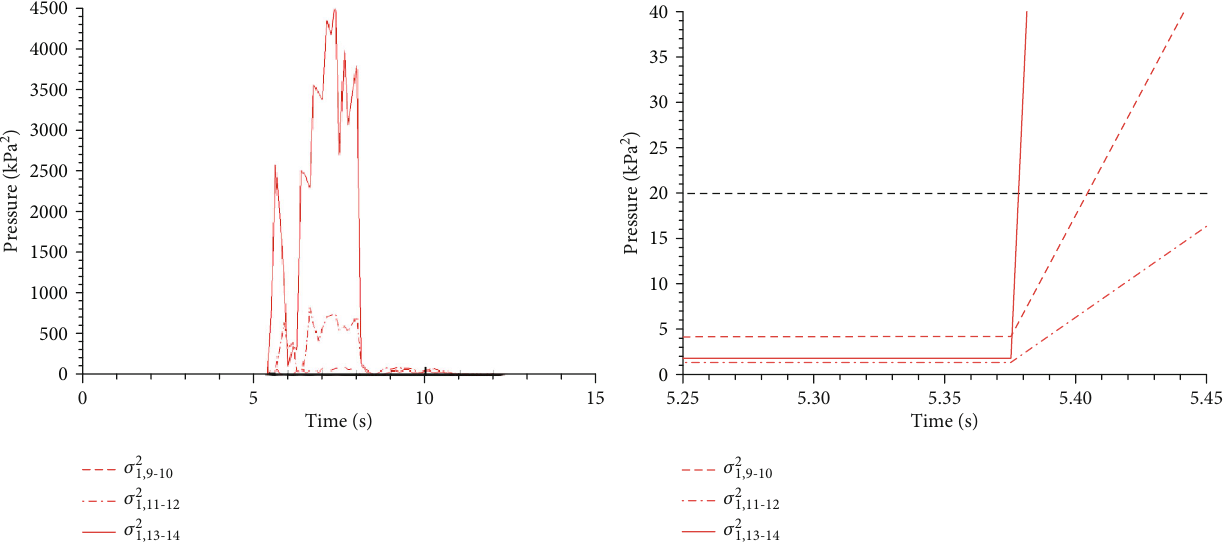
Figure 18: Variation of σ 2 1 at R2 inlet, S2 outlet, and compressor